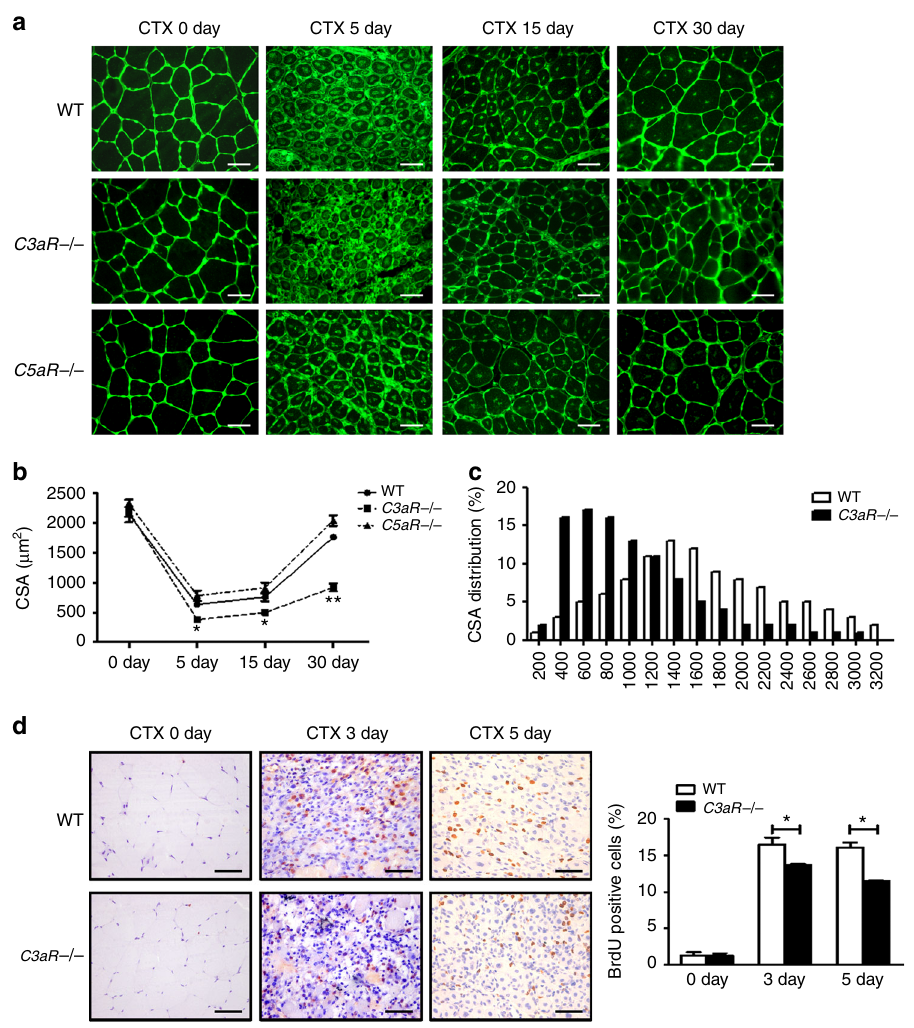
Fig. 5 Complement receptor C3aR de fi ciency impaired muscle regeneration. a At 0, 5, 15 and 30 days after injury, muscles from WT, C3aR − / − , and C5aR − / − mice were immune-stained with WGA (green). (Bars, 50 μ m). b The mean myo fi ber CSA in injured muscles from WT, C3aR − / − , and C5aR − / − mice were measured. ( N = 4 in each group). c The distribution of myo fi ber sizes of WT and C3aR − / − mice at 30 days after injury was analyzed, ~250 myo fi bers of each sample. d BrdU immunohistochemical staining was used to detect the proliferating cells in injured muscle (at day 3 and day 5 after injury) of WT and C3aR − / − mice, the percentages of BrdU positive cell per fi eld were analyzed. ( N = 4 in each group; bars, 50 μ m). Data are expressed as the mean ± s.e.m. * P < 0.05, ** P < 0.01, unpaired t -test,